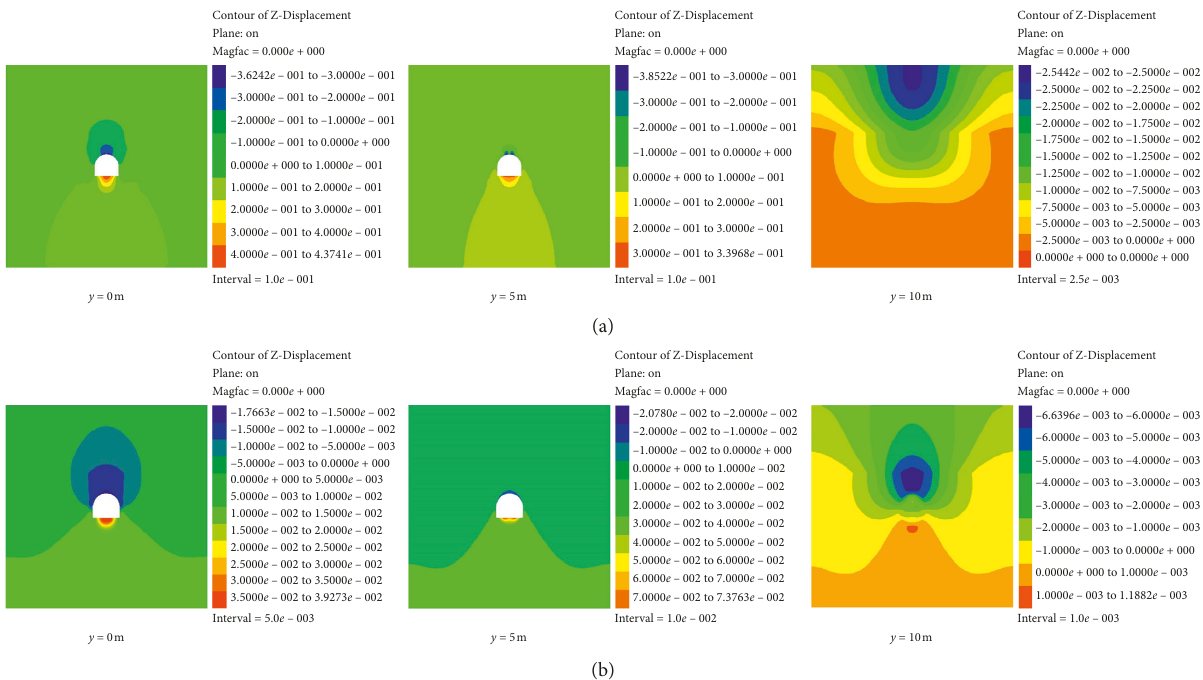
Figure 6: Vertical displacement changes of the tunnel floor after excavation: (a) plan A; (b) plan